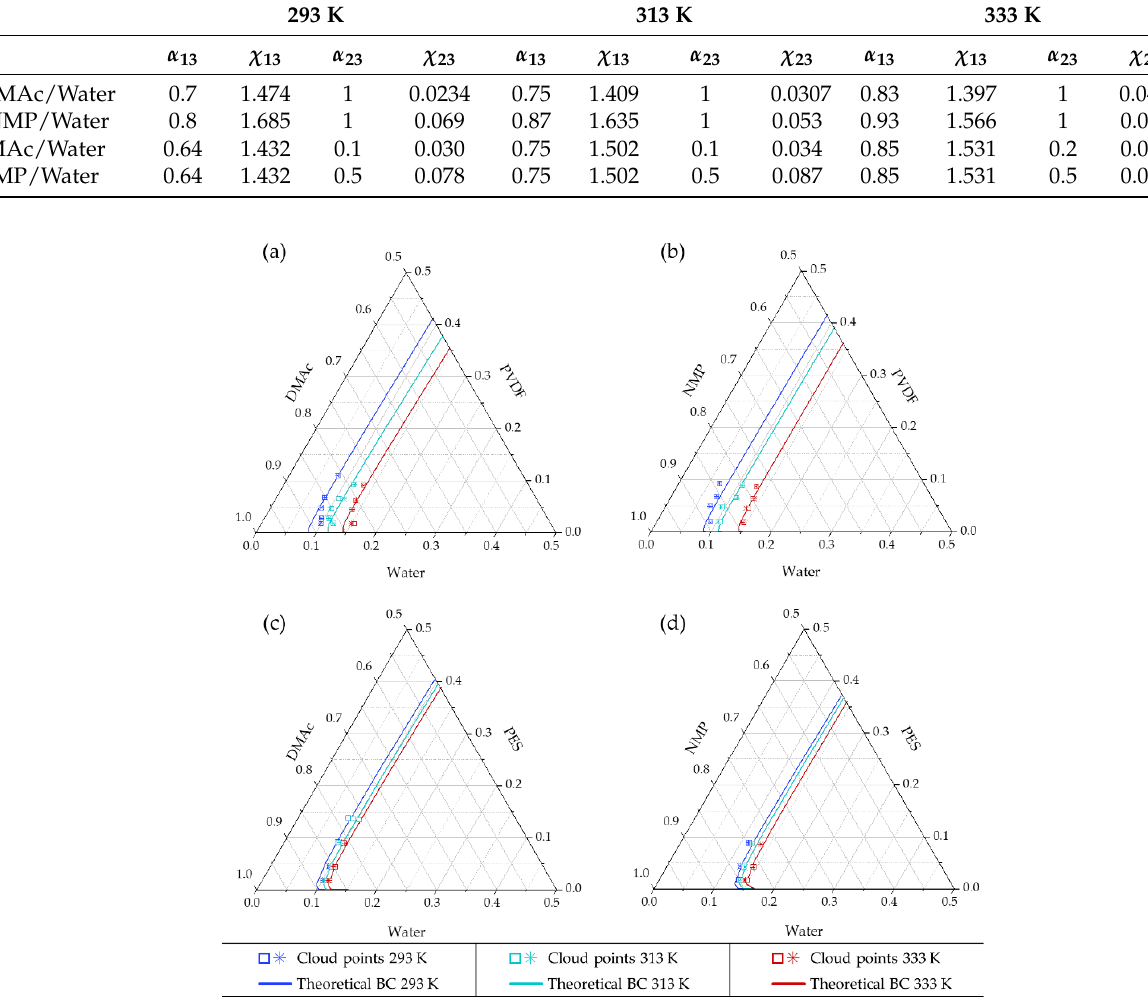
Table 7. Corrected binary interaction parameters χ ij with the corresponding correction constants α ij .